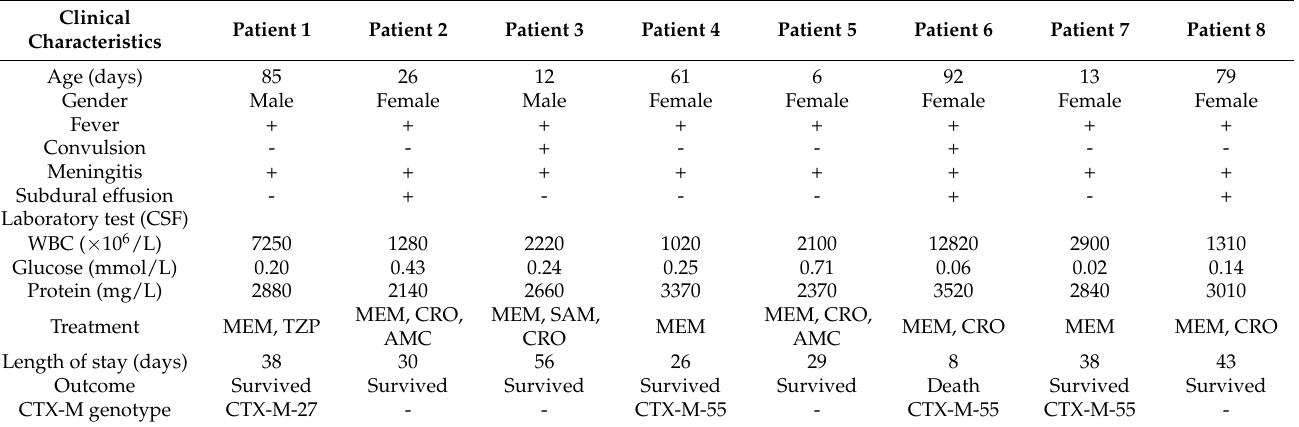
Table 3. Clinical characteristics and CTX-M genotype status in the eight patients with intracranial infections carrying ST1193